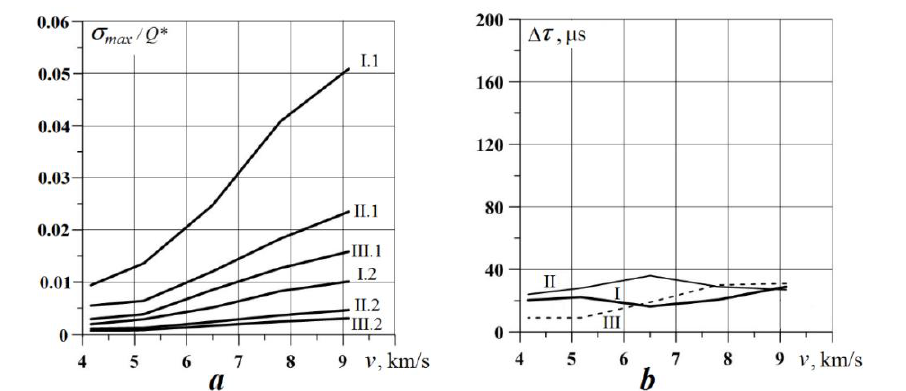
Fig 2. The dependence of the parameters of the tensile pulse at the wave front on the detonation velocity v at points at a distance: 20 r (I), 50 r (II), 75 r (III): a - the dependence of the maximum values of radial (1) and circumferential (2) tensile stresses; b - the dependence of the length of the pulse duration of tensile stresses ∆ τ